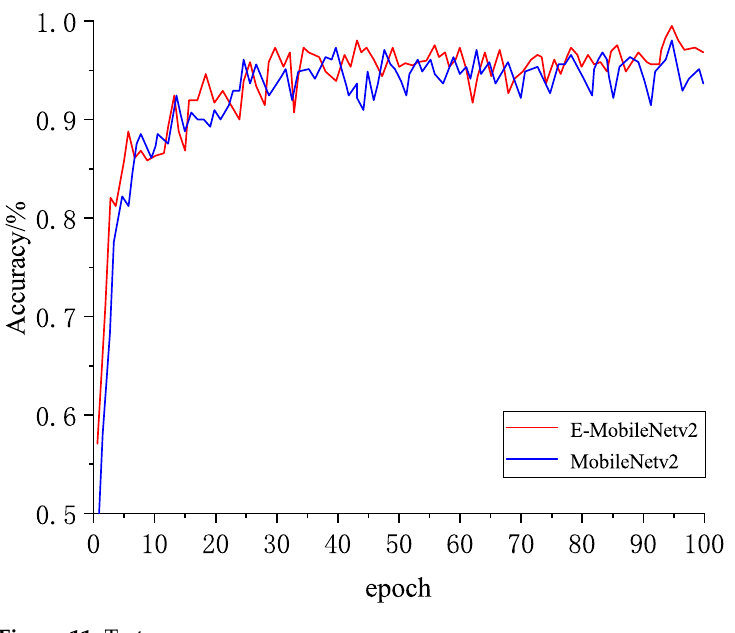
Figure 11. Test accuracy.